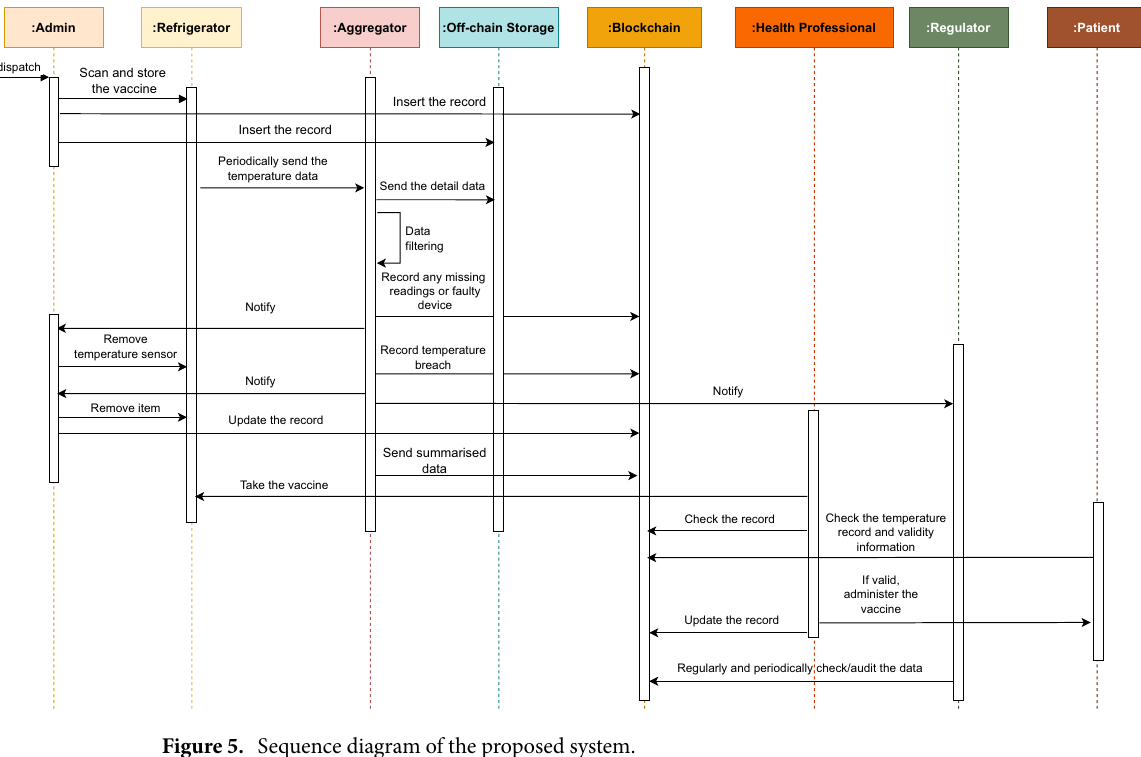
Figure 5. Sequence diagram of the proposed